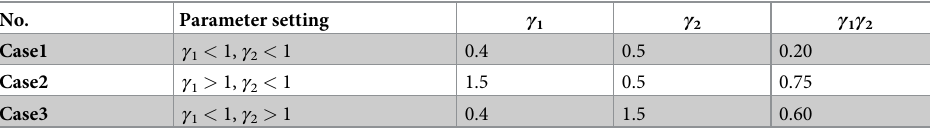
Table 1. Parameter selection value of equilibrium